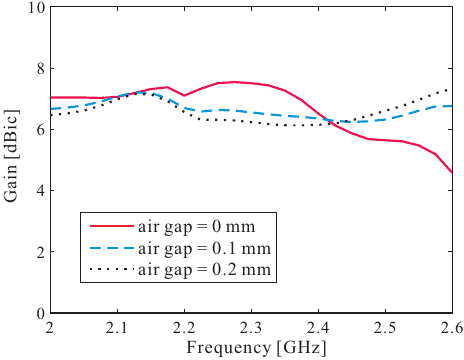
Figure 6. Effect of an air gap on antenna